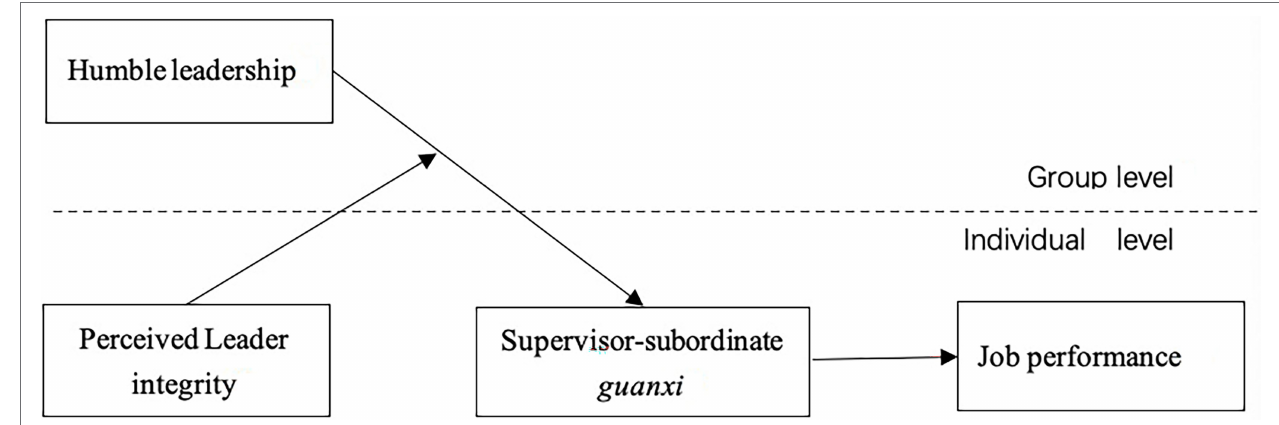
FIGURE 1 | The hypothetical